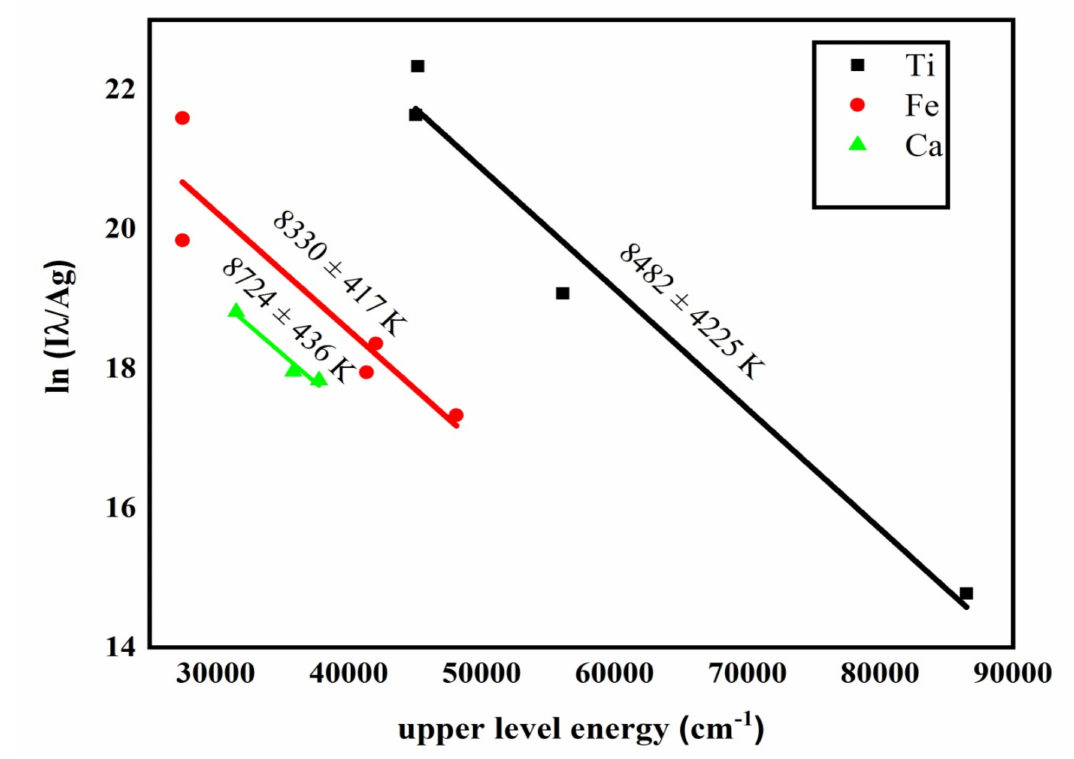
Figure 4. Boltzmann plot drawn for measurement of plasma temperature using spectral lines of Ti, Fe, and Ca. Table 2. Spectroscopic data of emission lines of Ti-I, Ca-I, and Fe-I used to draw Boltzmann